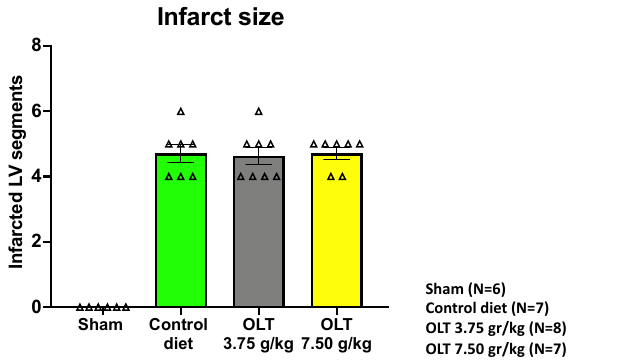
Figure 2. Assessment of the size of the infarct using transthoracic echocardiography 3 days after MI. Only the mice with four or more infarcted left ventricular segments out of a total of 16 (six segments at the base, six mid-ventricular segments, and four apical segments) were included in the study. Each triangle corresponds to the value measured in each mouse. The values are expressed as the mean ± SEM. As expected, at the baseline, when compared to the sham-operated mice ( n = 6), the mice that underwent AMI surgery had an 18% greater LVEDD ( p < 0.001) and a 57% lower LVEF ( p < 0.001). After 10 weeks, a further increase in LVEDD and decrease in LVEF was noted in the mice fed with the standard diet (Group 3), as well as in those fed with low- and high-dose OLT1177 ® in the diet (Groups 1 and 2, respectively), without significant differences between the groups (Figure 3).